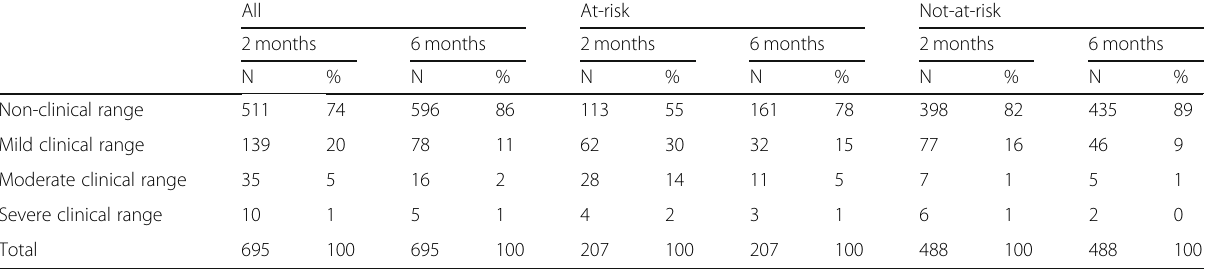
Table 2 Clinical levels of KPCS scores according to risk status and infant age at the time of assessment All At-risk Not-at-risk 2 months 6 months 2